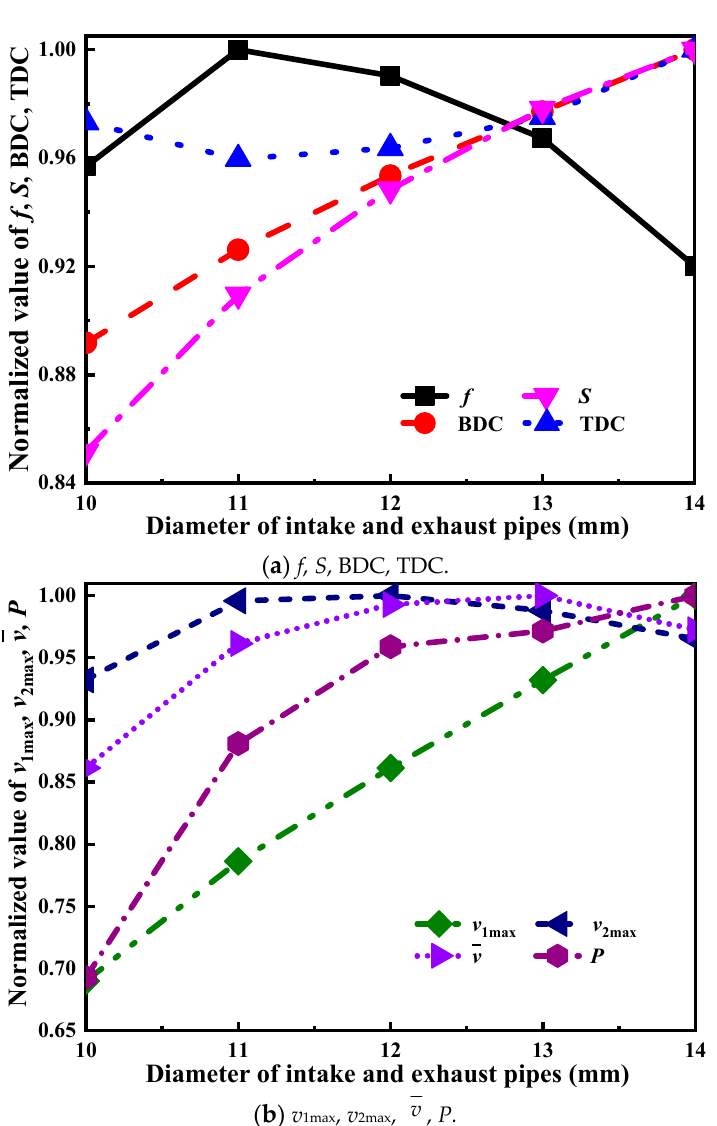
Figure 10. Variation of performance parameters with diameter of intake and exhaust pipes.